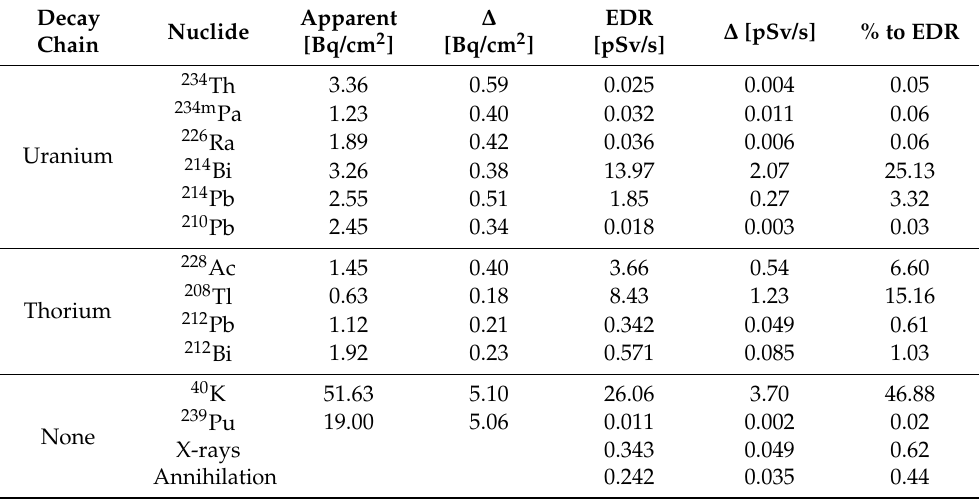
Figure 3. Gamma-ray spectrum registered in situ in blind chamber excavated in sandstone, in the EM ‘Barbara’, using HPGe detector, with main visible peaks. Table 1. Effective dose rate (EDR), with the relative contribution (%) to each radionuclide to EDR, and total apparent activity associated with each source of photon radiation recognized at the spectrum registered in situ.